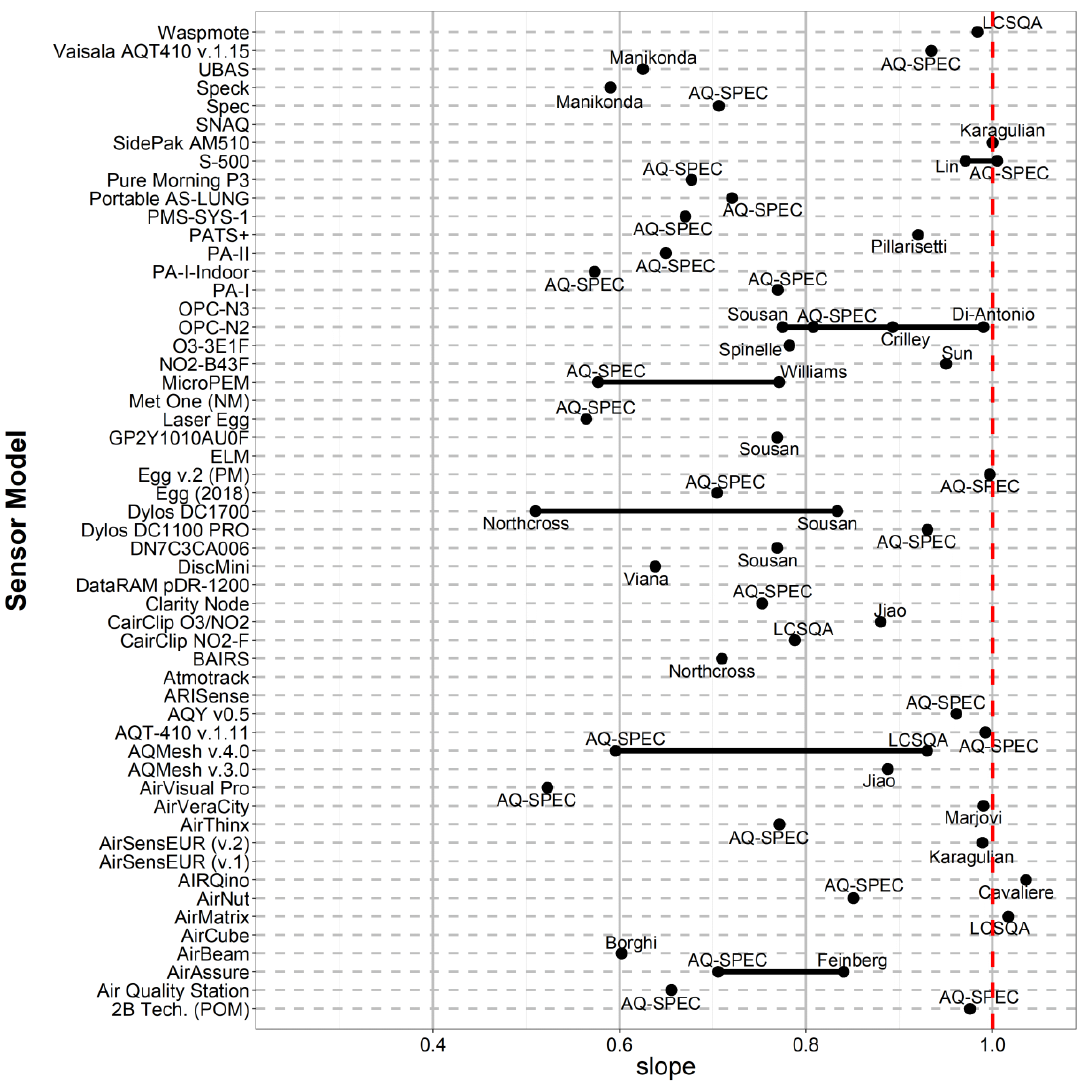
Figure A12. Mean slope obtained from the comparison of LCS against reference measurements.